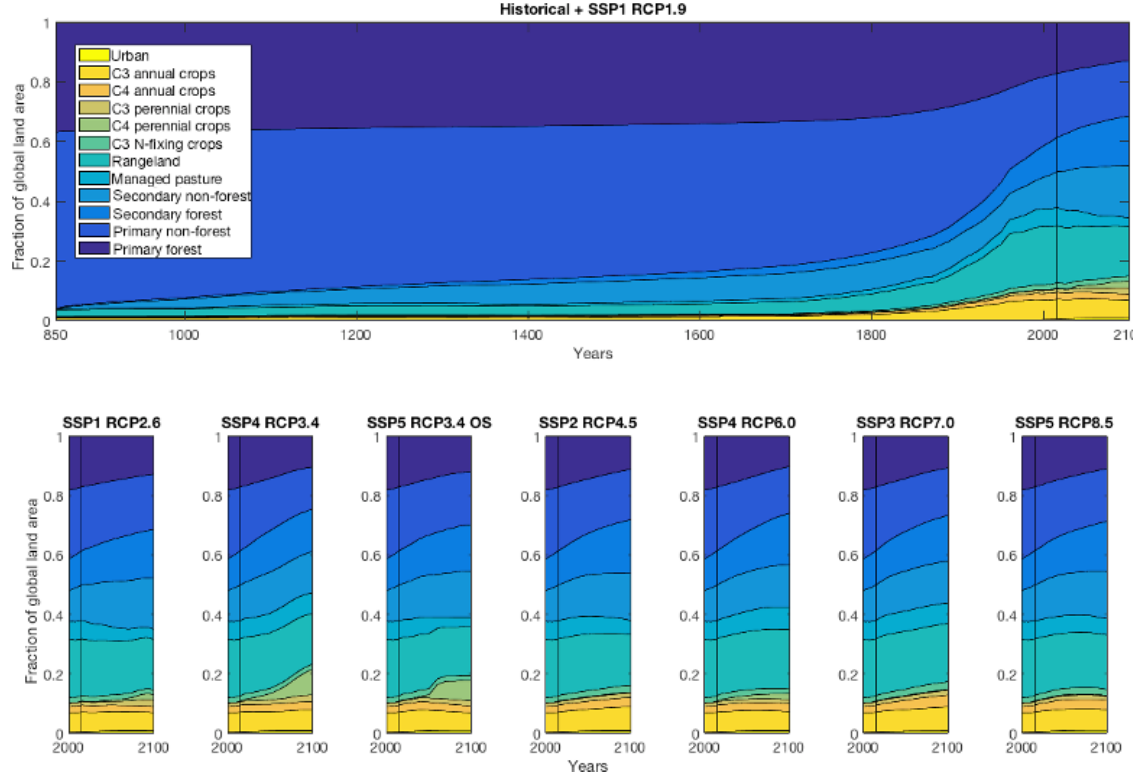
Figure 7. Harmonized global land use area fractions 850–2015 (baseline historical) and 2015–2100 for the eight future